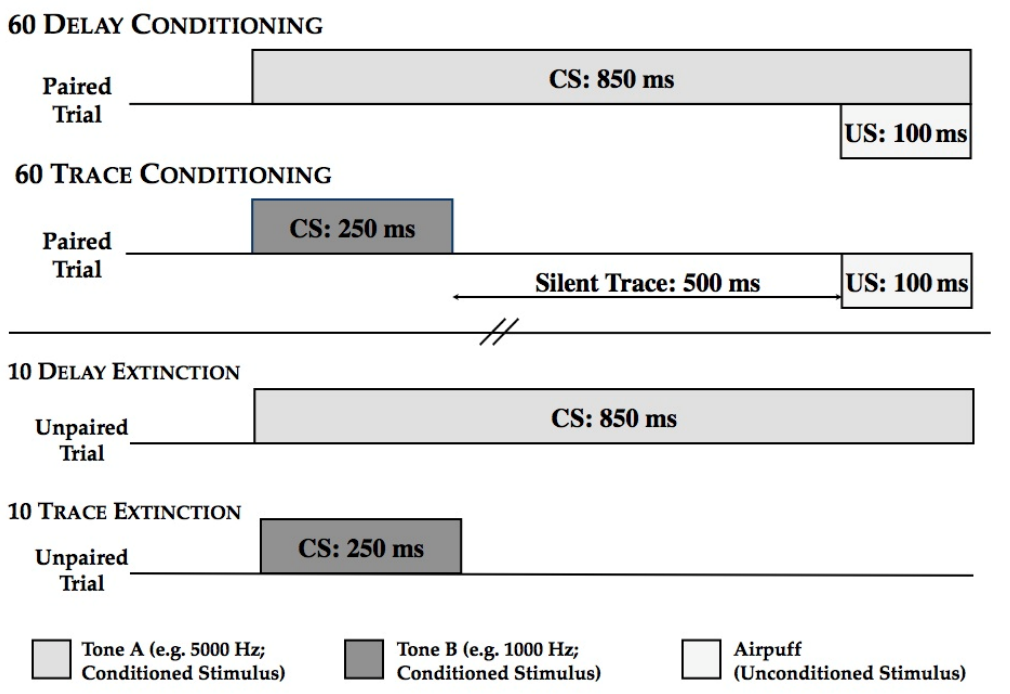
Figure 1. Schematic of the concurrent delay and trace